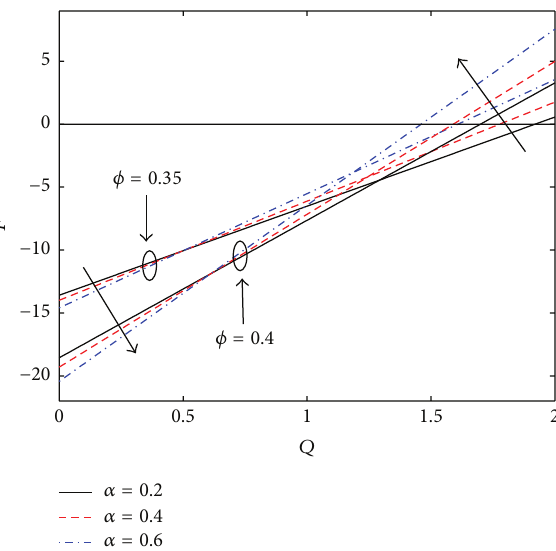
Figure 8: Frictional force on the inner tube 𝐹 (𝑖) versus the time- averaged flow rate 𝑄 for different values of heat parameter 𝛽 and the Grashof number Gr with 𝜆 1 = 1 , 𝛼 1 = 0.4 , 𝜀 = 0.35 , 𝜙 = 0.4 , and 𝑡 = 1 .